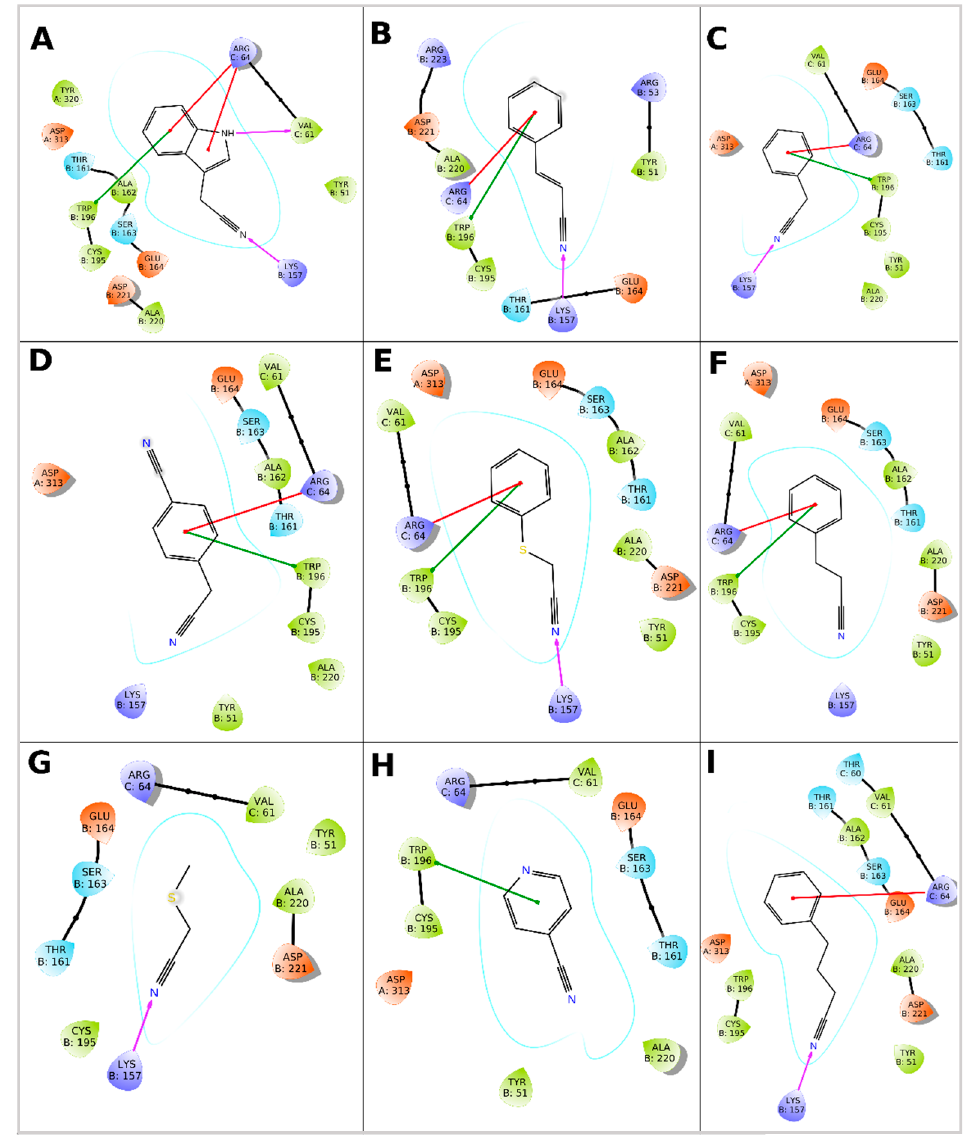
Figure 3. Interaction of NitAb with docked ligands: ( A )—Indole-3-acetonitrile; ( B )—cinnamonitrile; ( C )—phenylacetonitrile; ( D )—4-cyanophenylacetonitrile; ( E )—phenylthioacetonitrile; ( F )—3-phenylpropionitrile; ( G )—methylthioacetonitrile; ( H )—4-cyanopyridine; ( I )—4-phenylbutyronitrile. The monomers are named A, B, C. The ligand is docked in monomer B.